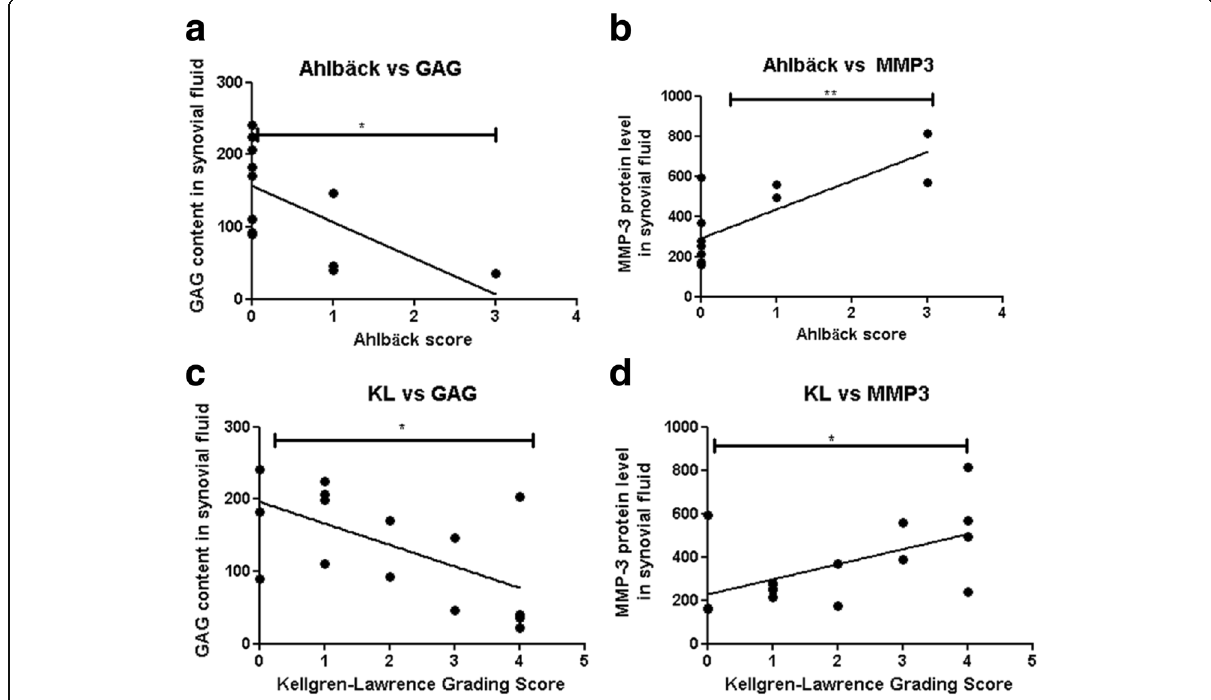
Fig. 3 MMP-3 and GAG levels correlate with Ahlb ӓ ck and Kellgren-Laurence (KL) radiographic scores. a Ahlb ӓ ck vs GAG; b Ahlb ӓ ck vs MMP-3; c Kellgren-Laurence vs GAG; and d Kellgren-Laurence vs MMP-3 levels in the synovial fluid of all knees ( n =